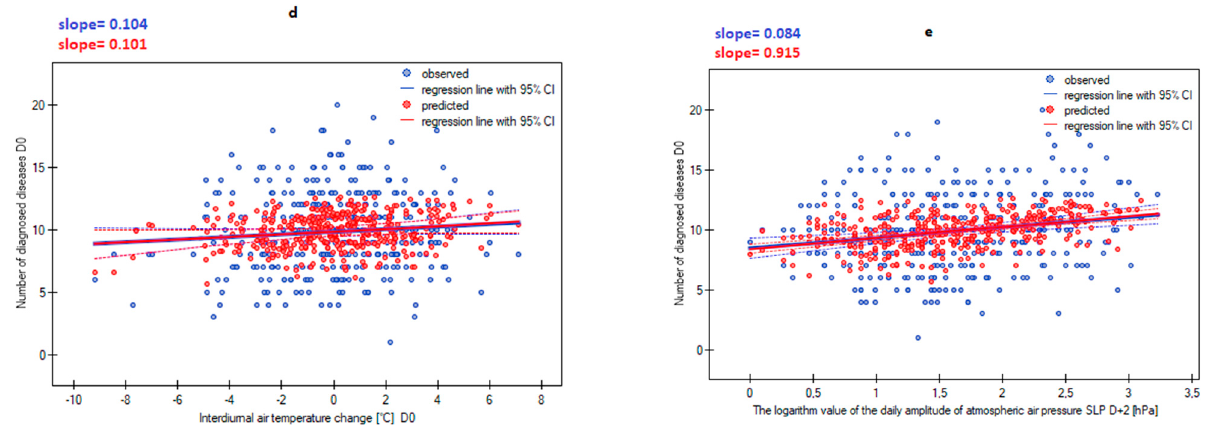
Figure 2. Summary of the number of diagnosed diseases and those predicted by the model, depending on: days of the week, season, maximum daily air temperature, interdiurnal change in air temperature, and the logarithm of the amplitude of daily atmospheric pressure. It was developed in the PQStat v1.8.4 program. ( a ) Averages determined depending on the day of the week with 95% confidence intervals for the observed number of calls and the number of calls predicted by the model. ( b ) Averages determined depending on the season with 95% confidence intervals for the observed daily number of calls and the daily number of calls predicted by the model. ( c ) Determined regression lines with a 95% confidence interval for the dependence of the daily number of calls on the maximum temperature recorded three days in advance in the summer and the cold season. ( d ) Determined regression lines with a 95% confidence interval for the dependence of the daily number of calls on the inter-day change in air temperature. ( e ) Persistent regression lines with a 95% confidence interval for the dependence of the daily number of reports on the logarithm of the daily amplitude of atmospheric pressure recorded with a two-day delay.